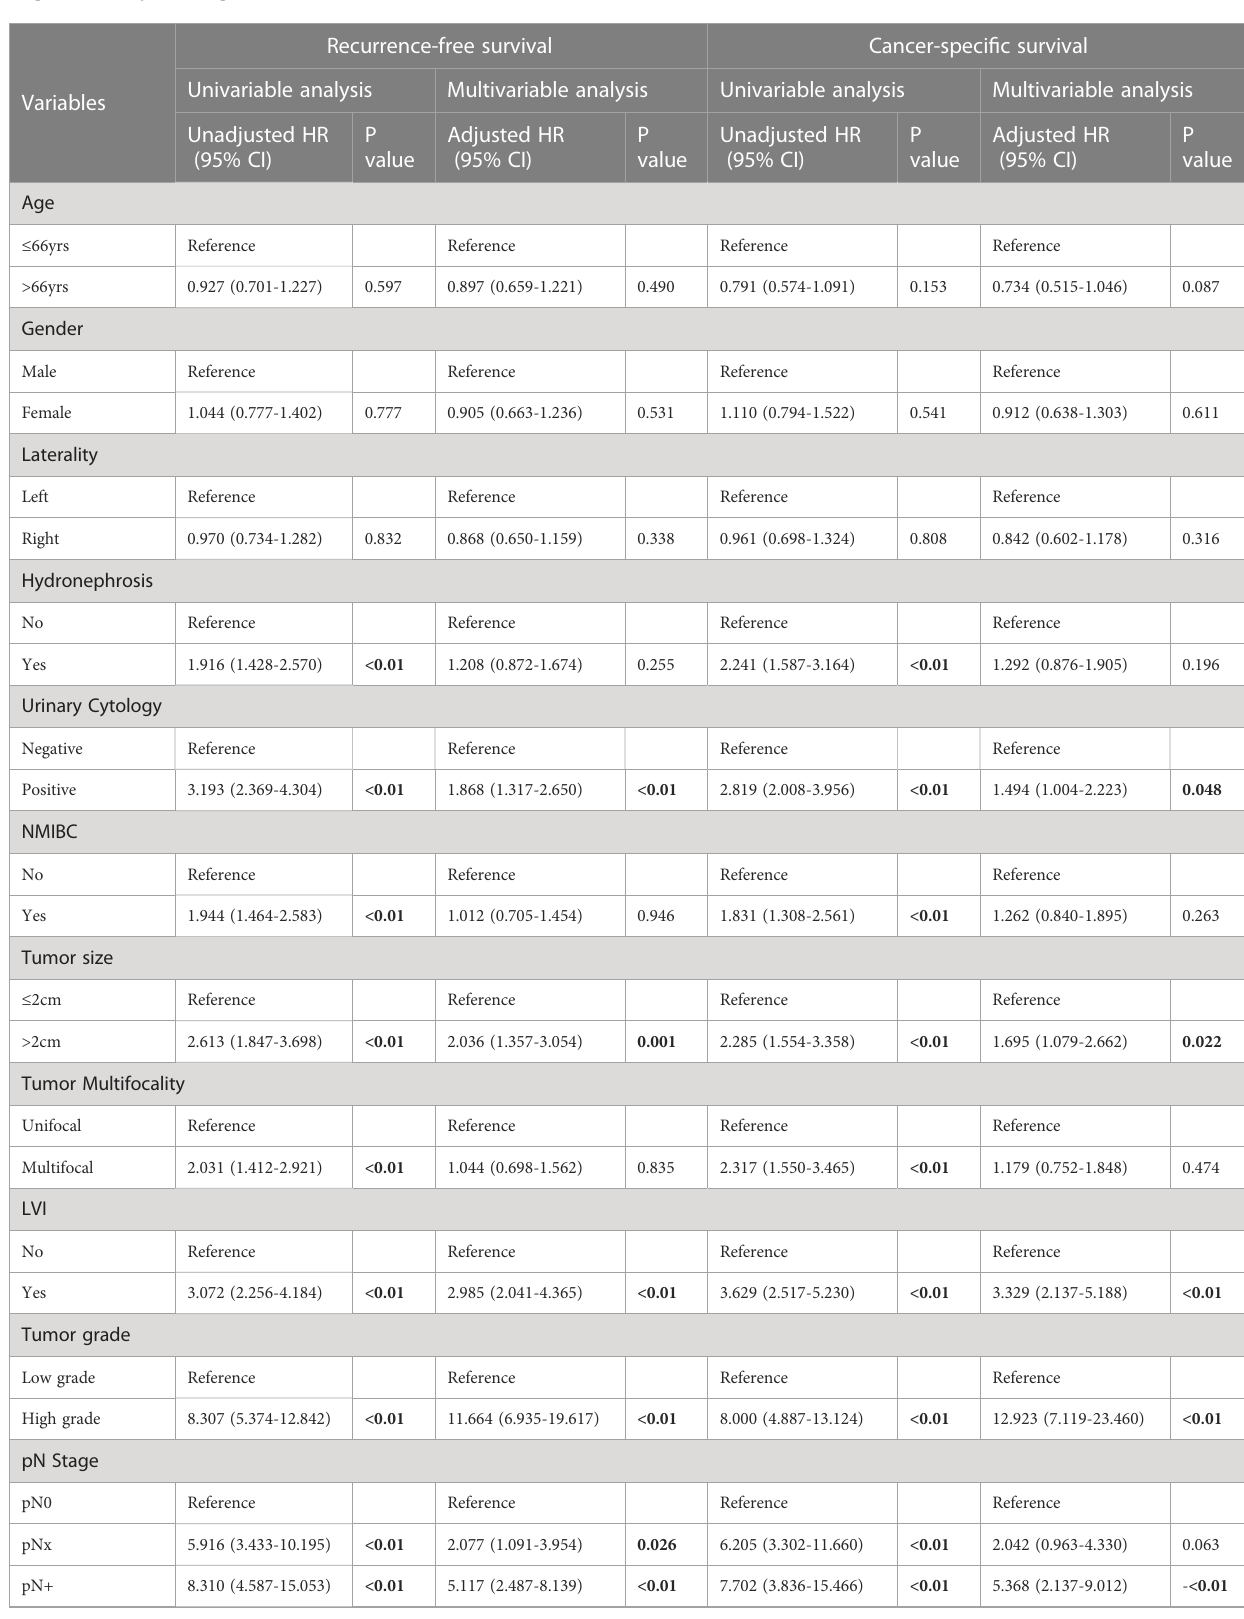
TABLE 3 Univariable and multivariable Cox proportional hazard models predicting recurrence-free survival and cancer-speci fi c survival in patients diagnosed with pT2-4